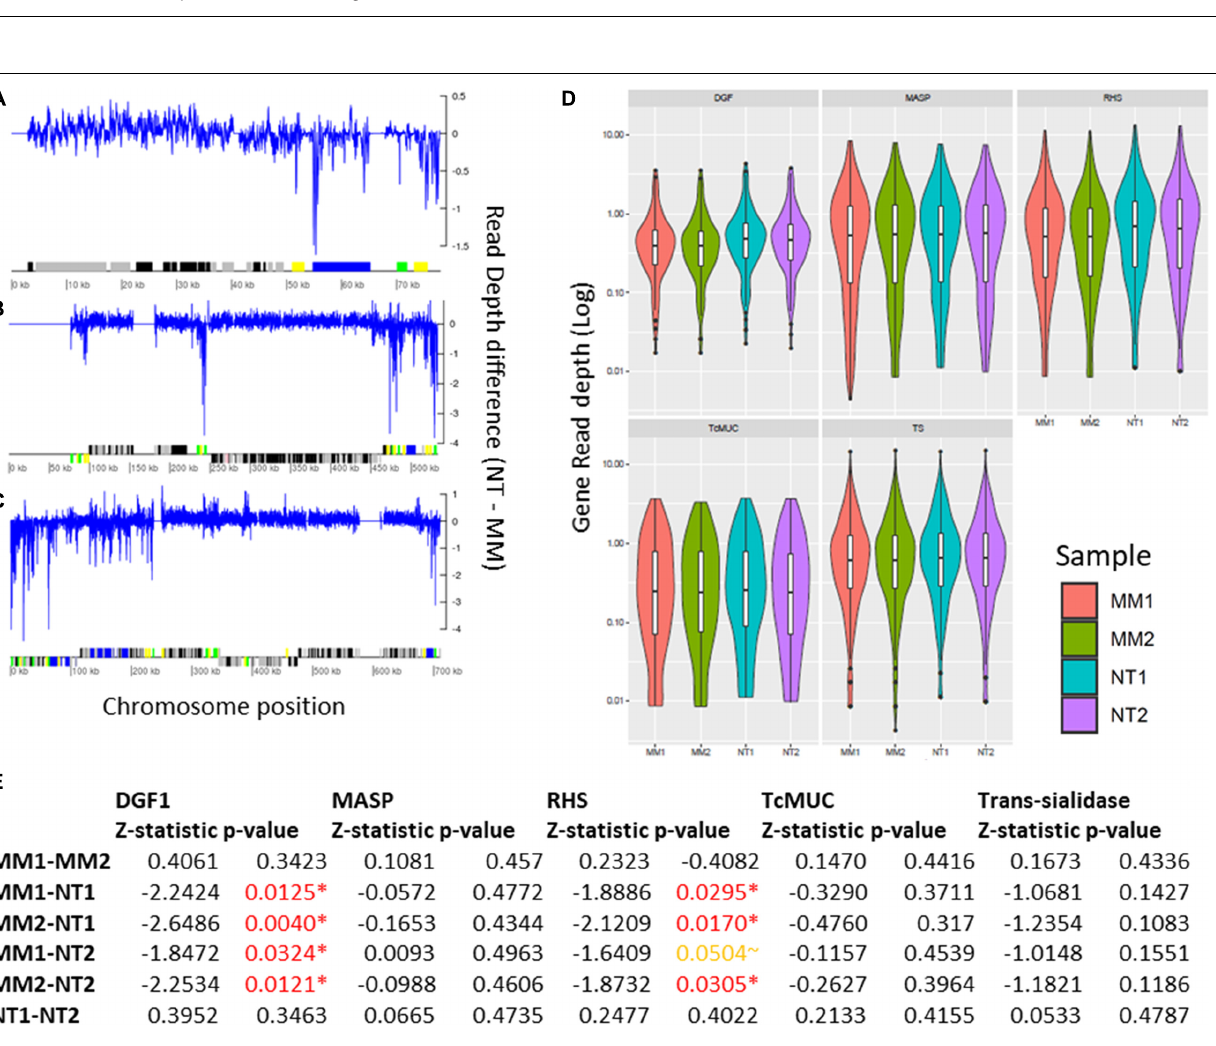
Frontiers in Cell and Developmental Biology |